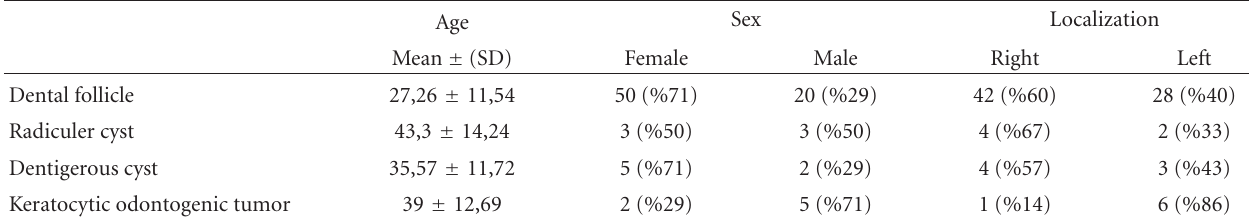
Table 2: Mean Ki-67 and MCM-2 expressions in all specimens. Dental follicle Radicular cyst